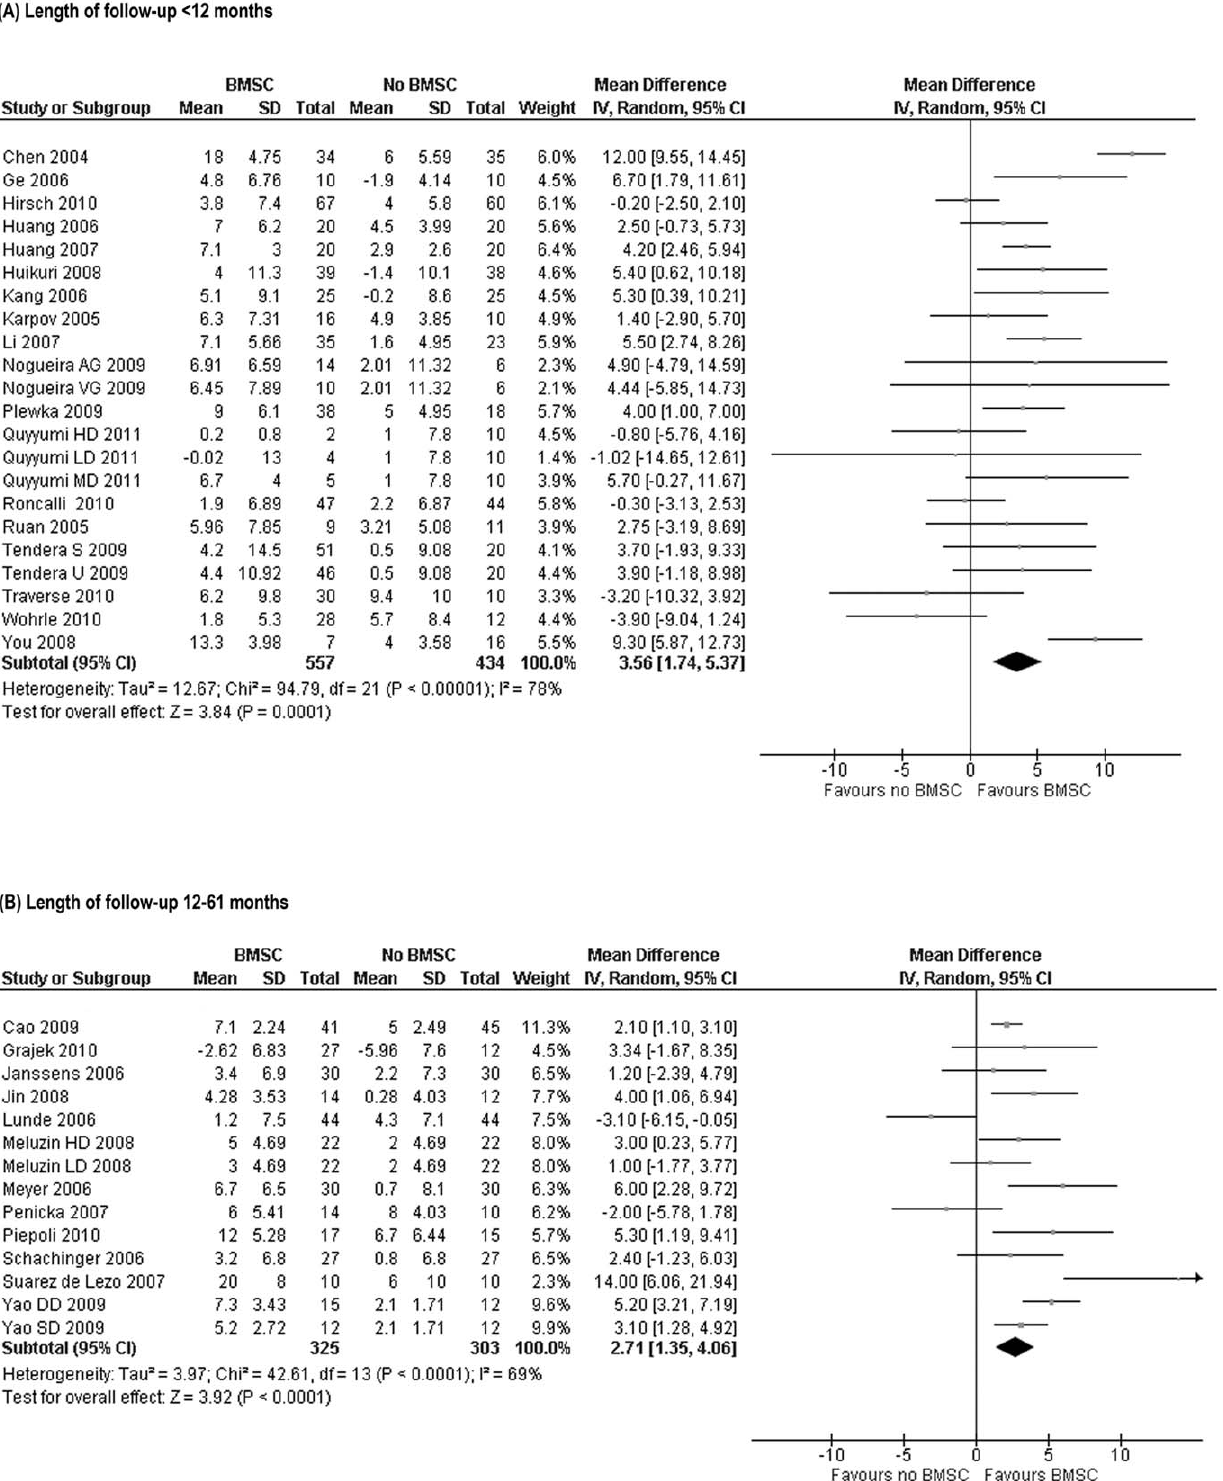
PLoS ONE | www.plosone.org